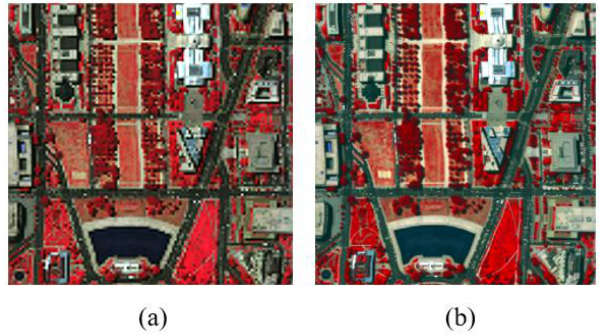
Figure 8. ( a ) MAP result in MTC; ( b ) Pansharpening result in PTC. Table 1. Super-resolution reconstruction errors for different classes.